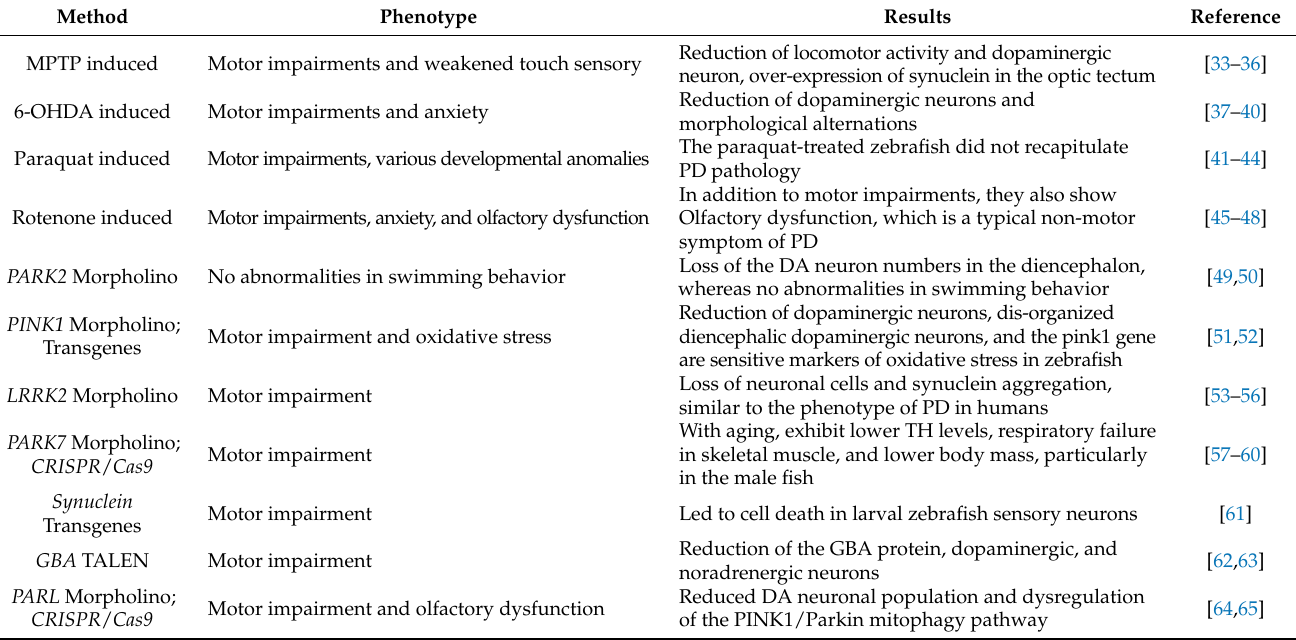
Table 1. Zebrafish models of Parkinson’s